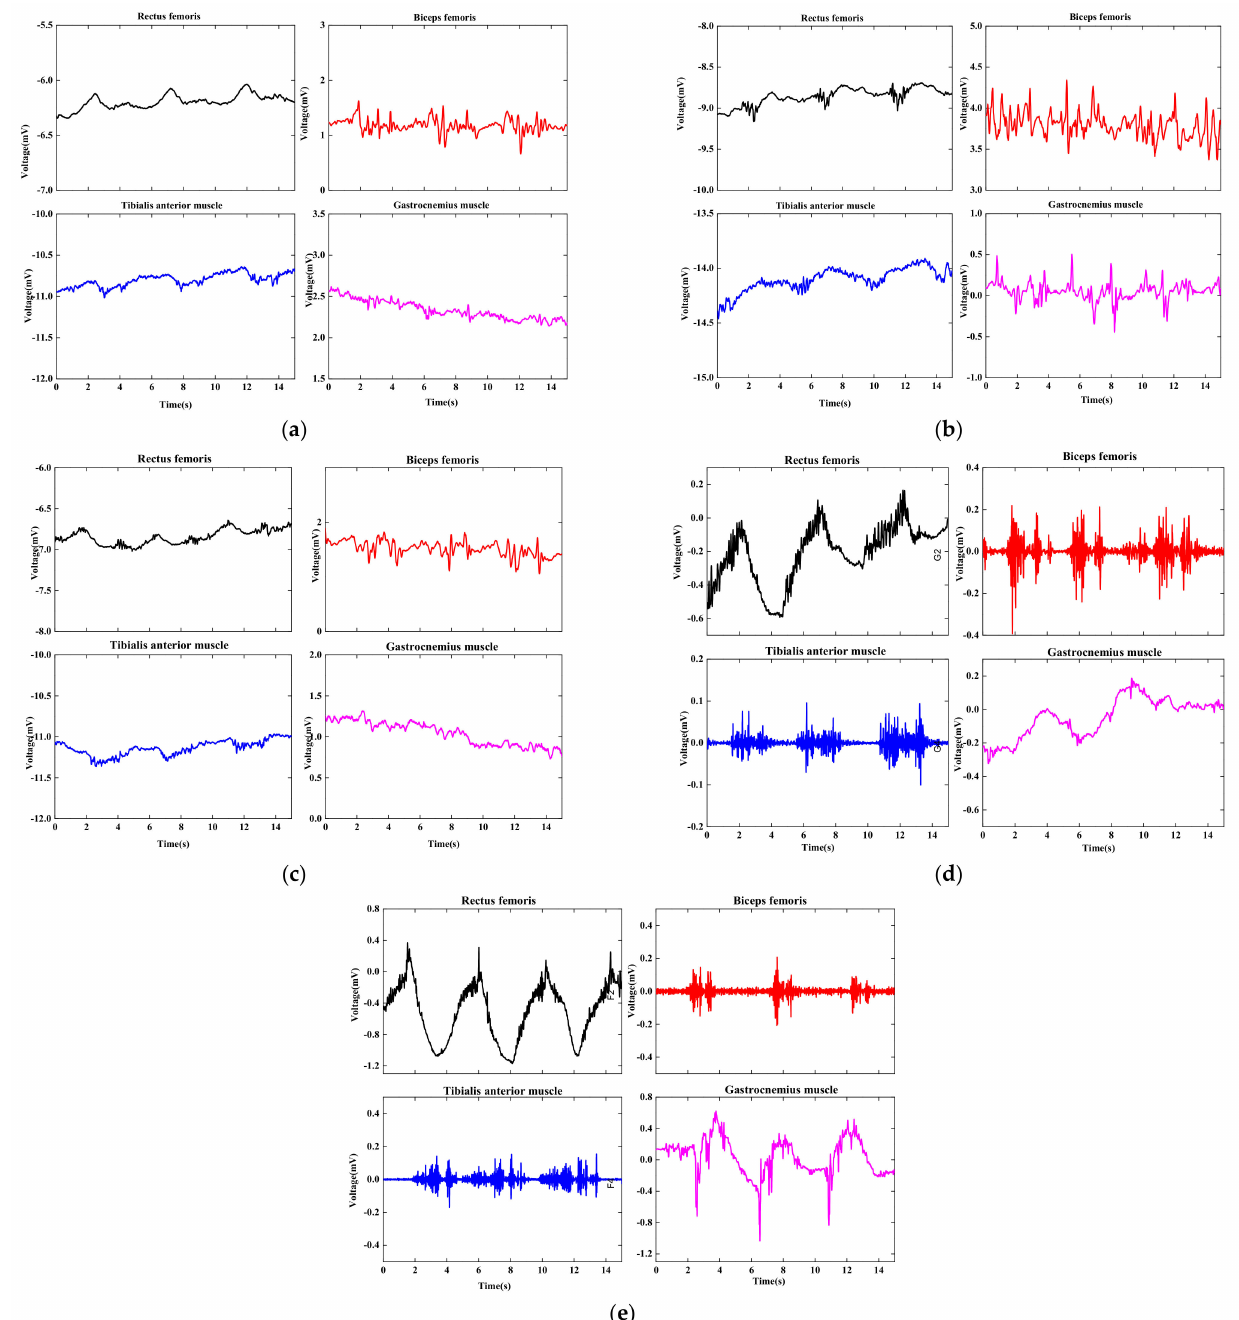
Figure 12. EMG of lower limb in different gait. ( a ) Flat ground; ( b ) uphill; ( c ) downhill; ( d ) squat; ( e ) side squat. The lower limb angles of 5 different gaits under 3 different surface conditions are similar but there are still some differences. Based on this finding, we collected the EMG signals of lower limbs in 5 kinds of gait and used those EMG signals as the input of the double hidden-layer BP neural network to identify 5 kinds of gait. The number of nodes in the input layer of the BP neural network is 20 (a 20-dimensional characteristic matrix of 4 muscles), the number of nodes in the hidden layer is 15, and the number of nodes in the output layer is 5 (5 kinds of gait). The results are shown in Figure